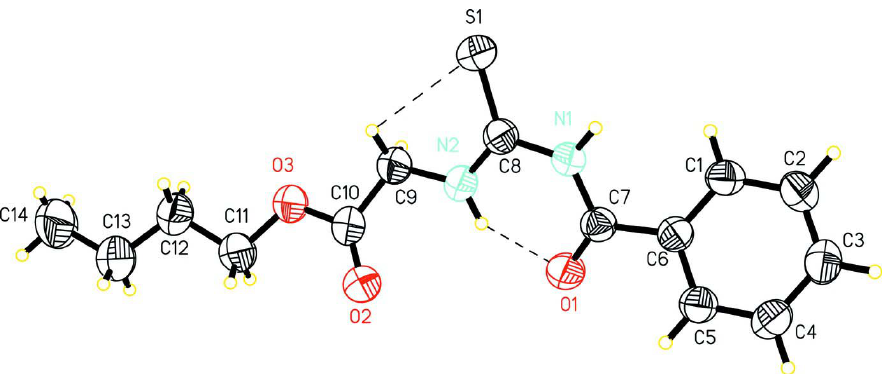
Figure 1 The molecular structure of (I) showing the main (80% occupancy) disorder component of the butyl terminal carbon atom, with displacement ellipsods are drawn at the 50% probability level.